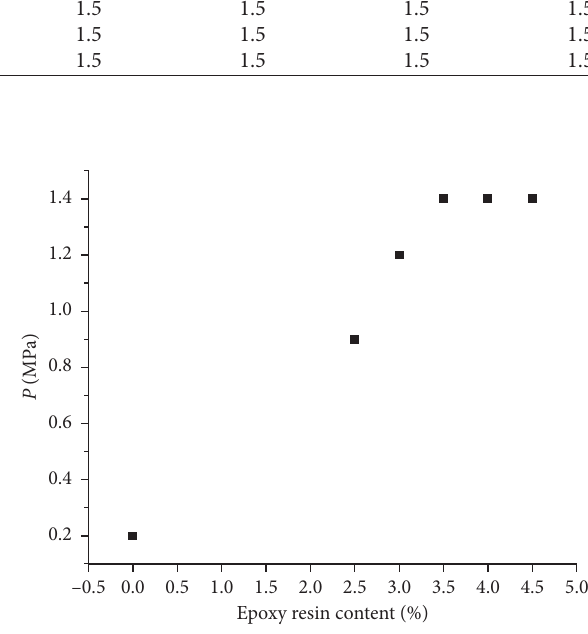
Figure 12: Impermeability pressures, P of FC specimens containing different amounts of EP. Table 7: Permeability coefficients of specimens b3, b4, and b5. Test specimen